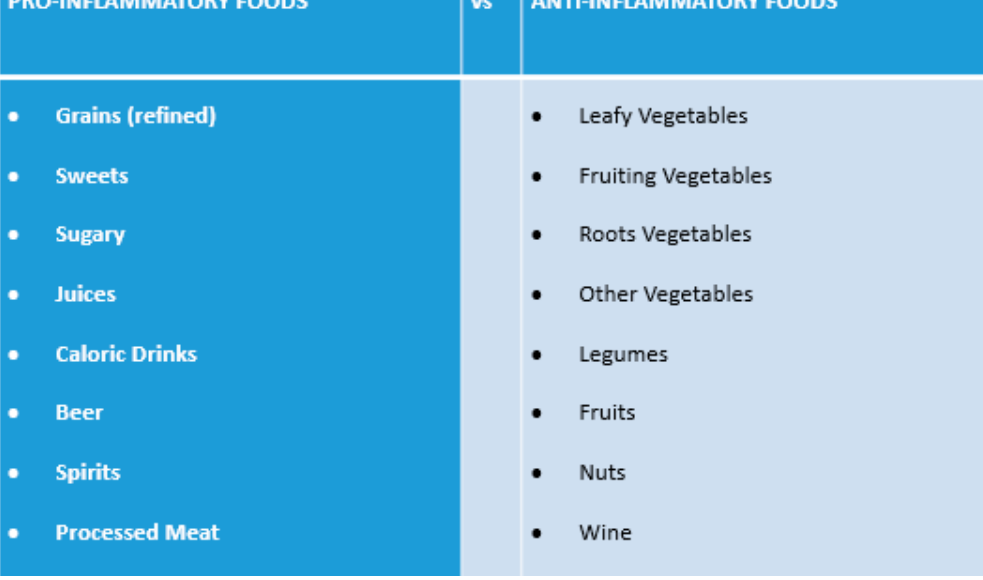
Figure 1. Classification of pro-inflammatory and anti-inflammatory foods, in accordance with the food groups used for the statistical analysis.